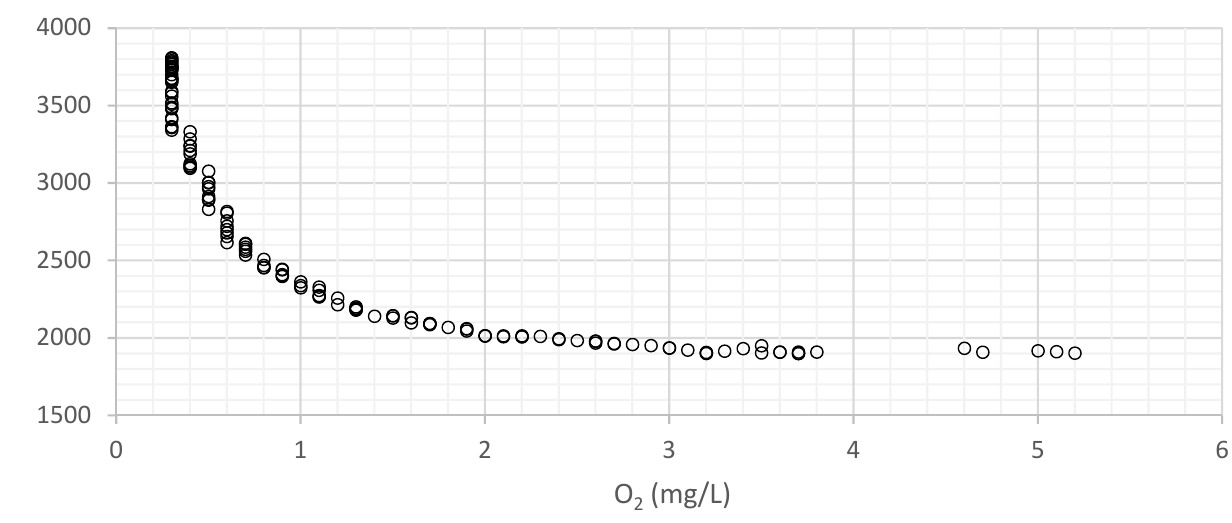
Figure 13. Variation of the DO values measured by the developed sensor as a function of the reference DO values (meas- ured with the commercial sensor) for the membrane with a concentration of 363 ppm with 1.4 mm and manufactured with THF, in a liquid environment, obtained with the Stern–Volmer equation (Equation (1)). The voltage values were acquired with the 12-bit ADC of the microcontroller (see details on Section 2.2). The ADC uses 12 bits of resolution and a reference (maximum) voltage of 3 V, so its resolution can be calculated in terms of voltage by Equation (6). 𝑅 (cid:3023)(cid:3042)(cid:3039)(cid:3047) = 3.2 4096 = 0.781 mV/bit